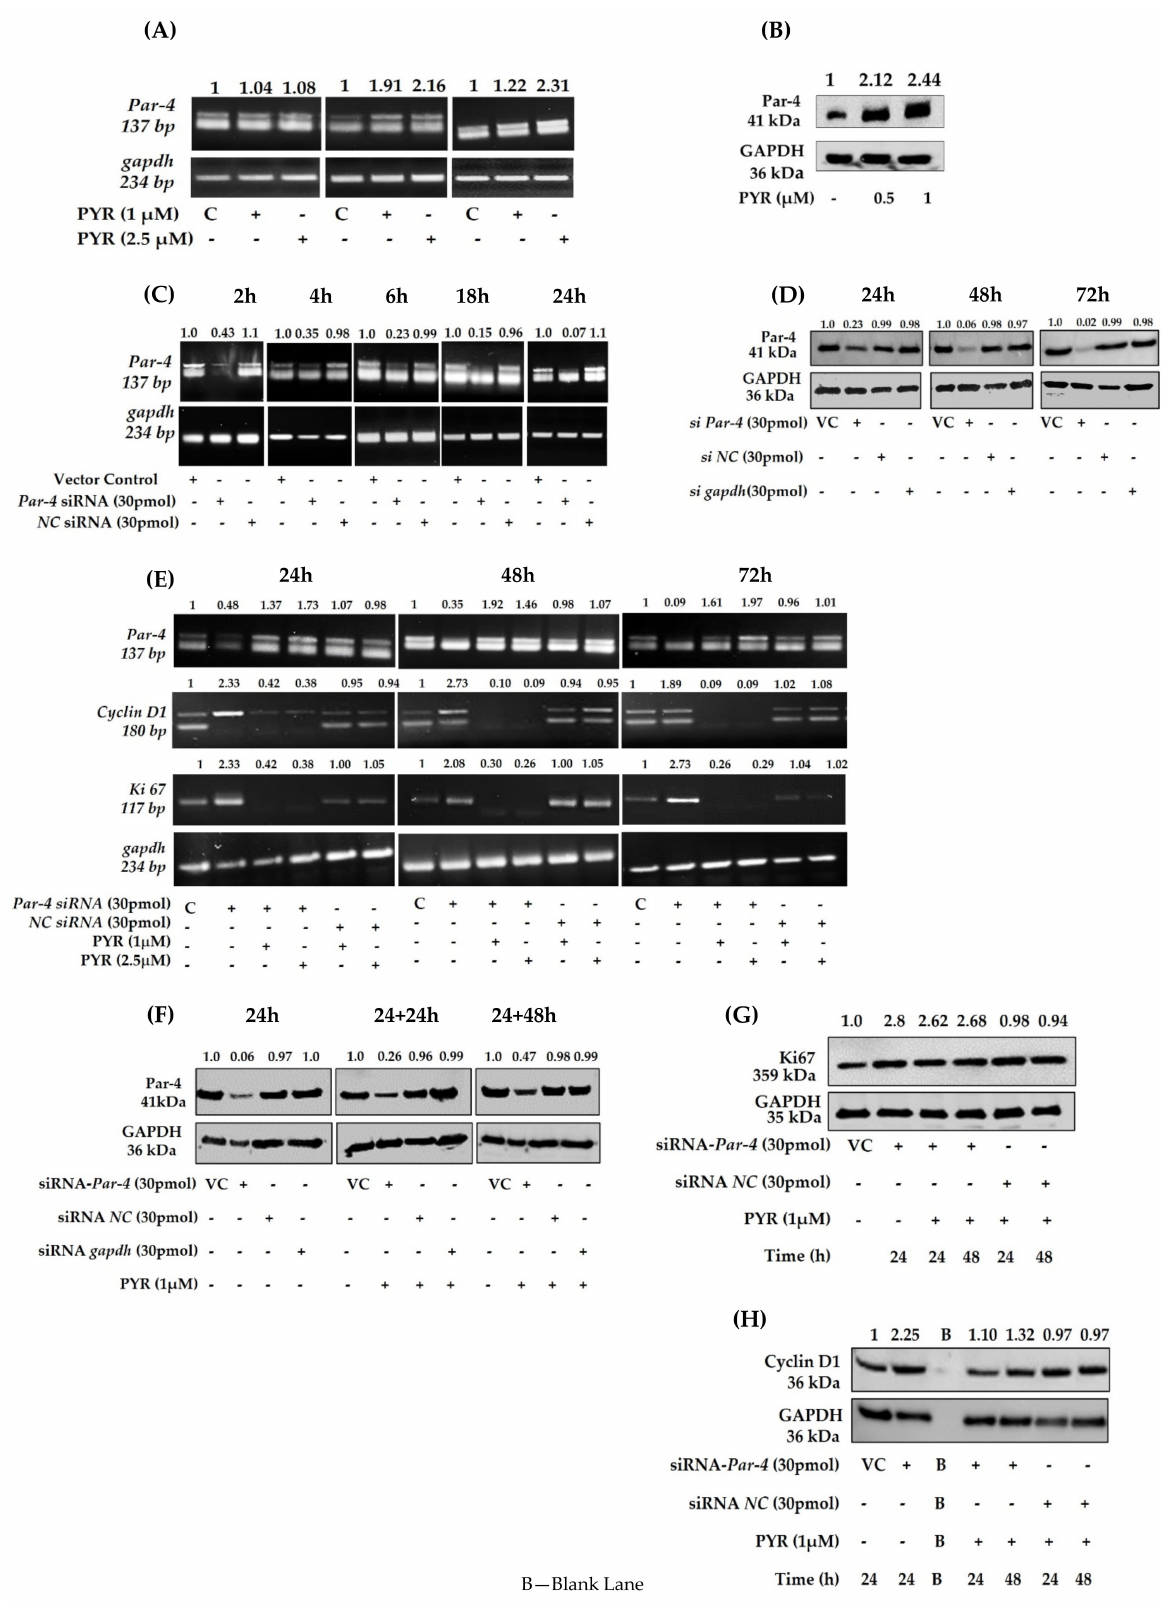
Figure 7. (A ) PYR (1 and 2.5 µ M) induced Par-4 mRNA transcript levels in U87MG cells 6, 18, and 24 h post-treatment. GAPDH was used as a loading control. ( B ) Par-4 protein expression levels in U87MG cells after PYR treatment at 0.5 and 1 µ M post 24 h. Figures on top indicate fold difference